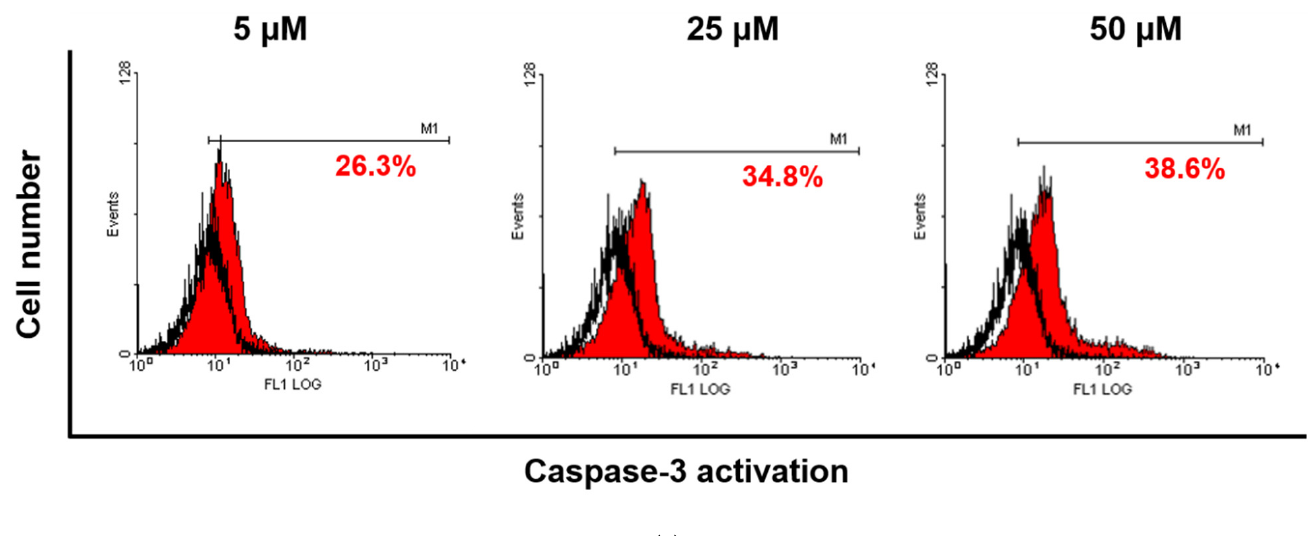
Figure 3. 5- epi -Sinuleptolide inhibits BxPC-3 cells proliferation and induces apoptosis. BxPC-3 cells were exposed to 5- epi -sinuleptolide at the indicated concentrations, and cell proliferation rate was measured via the bromodeoxyuridine incorporation assay after 24h. * indicates p < 0.05 vs. DMSO-treated control group, and ** indicates p < 0.01 ( a ). BxPC-3 cells treated with 5- epi -sinuleptolide for 24 h at the desired concentrations were stained with Annexin V-FITC and PI. The Annexin V-FITC signal is shown on the X -axis and the PI signal is shown on the Y -axis. Intact cells are located in the lower left quadrant, necrotic cells permeable to propidium iodide are in the upper left quadrant, and the apoptotic cells stained by annexin V and unstained by propidium iodide in the lower right quadrant. The bolded numbers represent the percentage of apoptosis or necrosis in the right lower or upper quadrant, respectively. ( b ). Caspase-3 activity of BxPC-3 cells treated with DMSO (open histogram) or 5- epi -sinuleptolide (red-filled histogram) for 24 h was measured by flow cytometry ( c ). FITC, fluorescein isothiocyanate; PI, propidium iodide; DMSO, dimethyl sulfoxide ( c ).